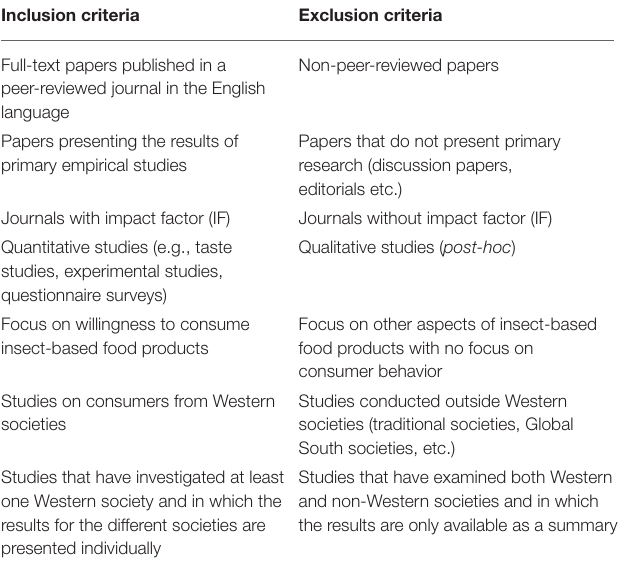
TABLE 1 | Inclusion and exclusion criteria for identifying relevant literature.